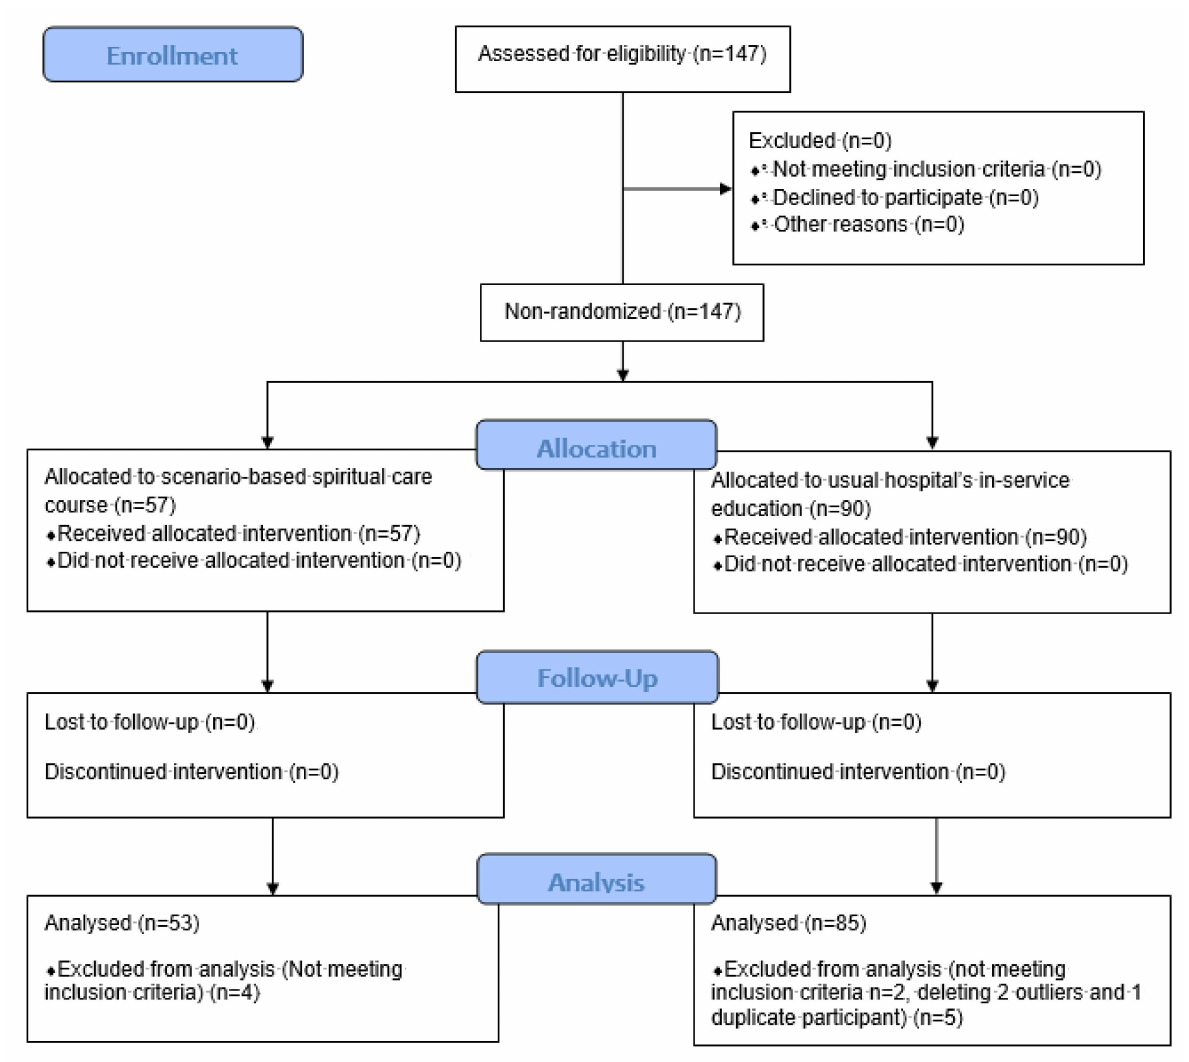
Figure 1. Flow diagram of the